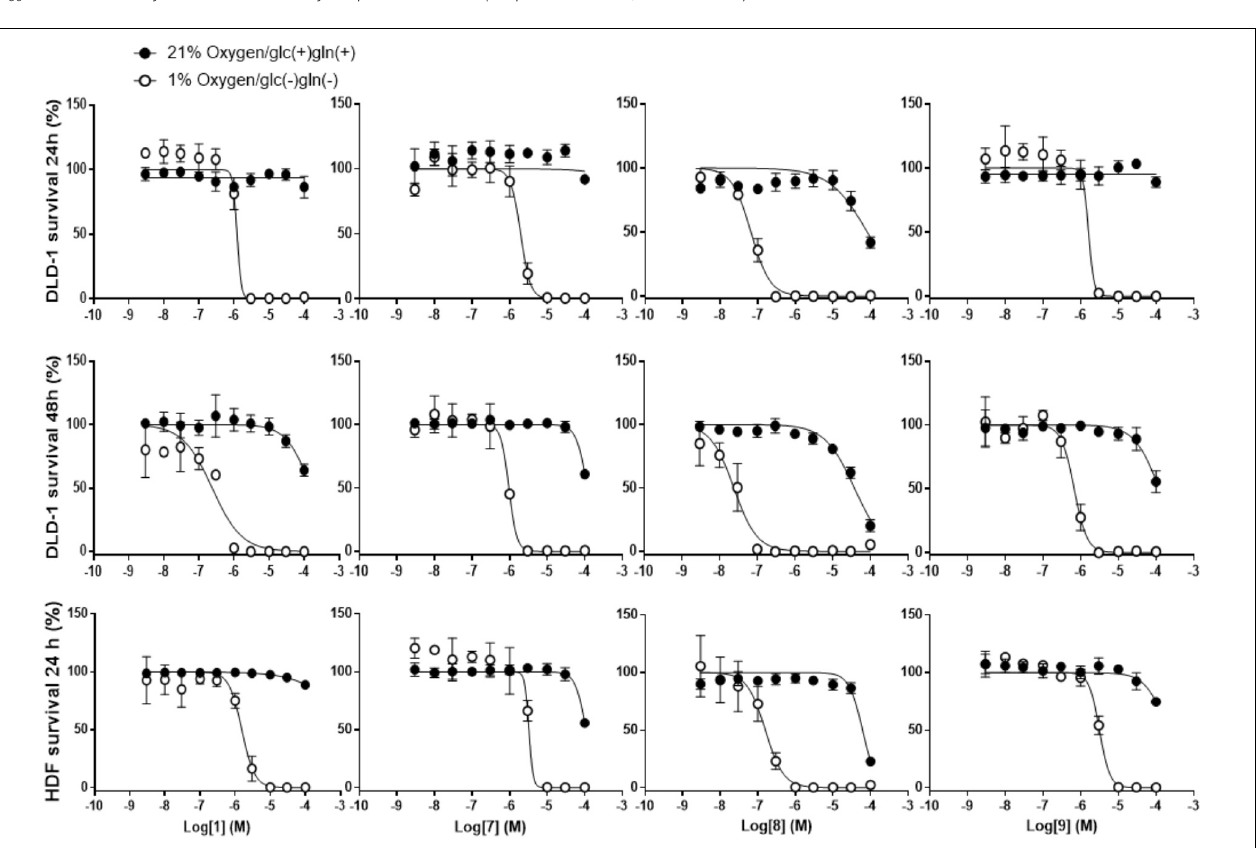
FIGURE 3 | Effects of 1 and its derivatives on survival of DLD-1 and HDF cells under normoxia/nutrient-rich conditions (circles) and hypoxia and nutrient-deprived conditions (square). (Top panels) Survival rates of DLD-1 cells in presence of 1 and its derivatives for 24 h were measured using WST-8 assay. (Middle panels) Similar experiment was performed, however, increasing the incubation time with HsDHODH inhibitors to 48 h. (Bottom panels) Same experiment as in top panels was conducted using HDF cells. Each lane of panels, from left to right, shows the data obtained by incubation of indicated cells with 1 , 7 , 8 , and 9 , respectively. All data represent the average from three independent